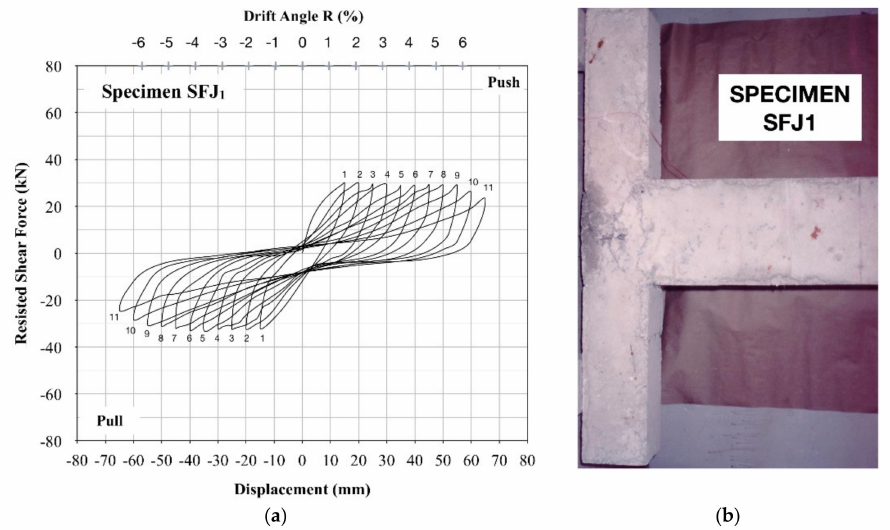
Figure 12. ( a ) Plots of resisted shear force versus displacement and ( b ) failure mode of subassem- blage SFJ1.